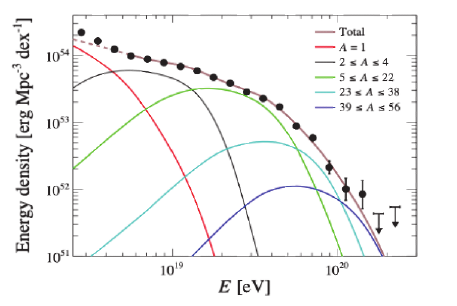
Figure 2: Energy densities with the fit for various